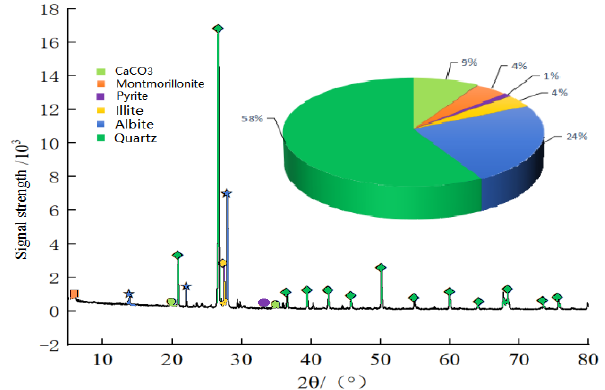
Figure 2. XRD pattern and mineral